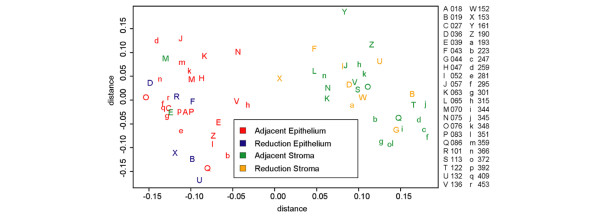
Multidimensional scaling of normal stroma and normal epithelium. Two tissue-specific clusters are observed. Adjacent and reduction tissue do not segregate into separate clusters. The epithelial tissue cluster contains two adjacent stroma sample outliers.